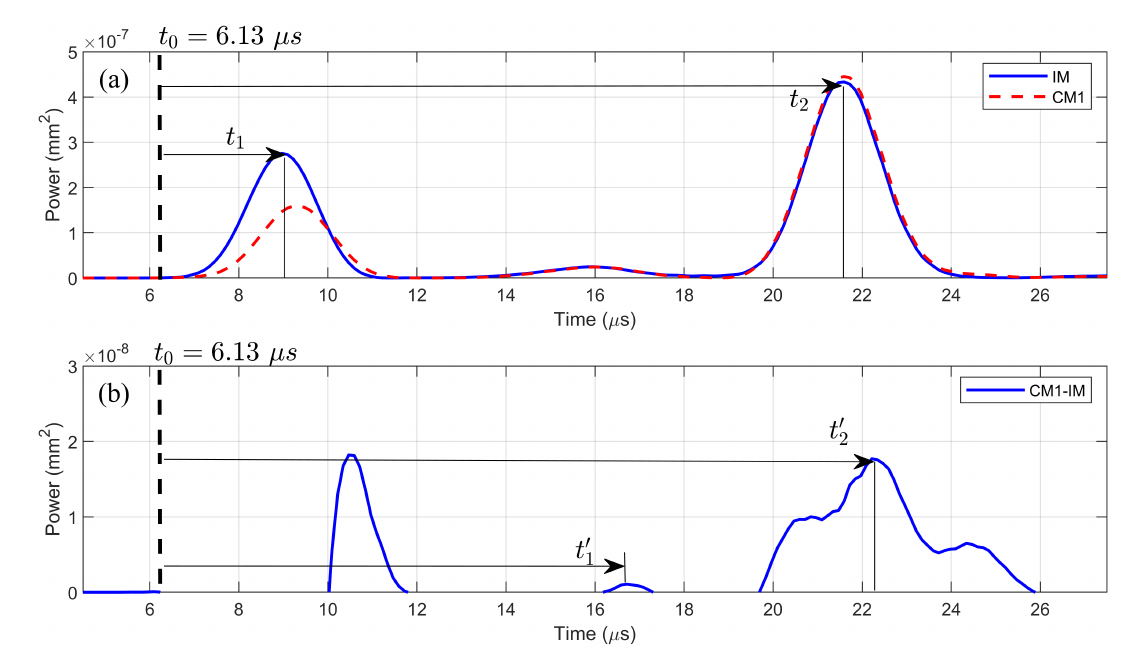
Figure 10. Spectrograms of model IM and model CM1 at 1